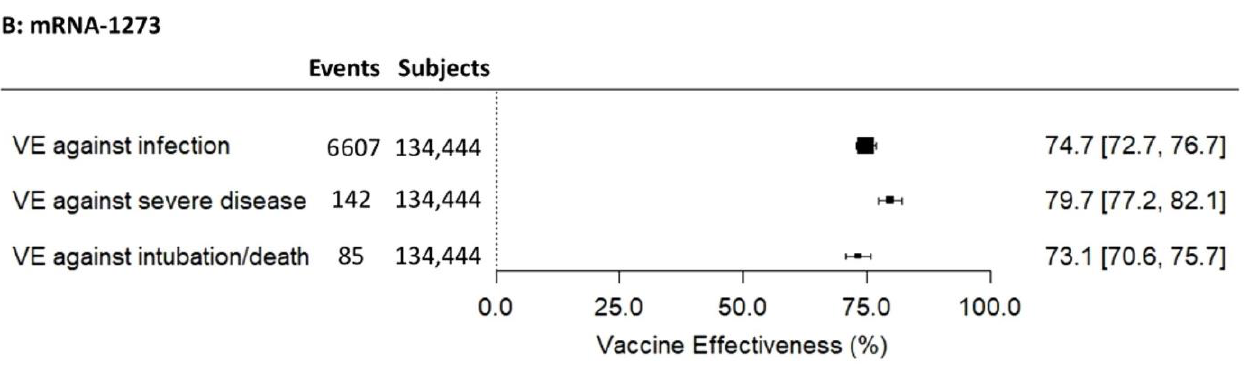
Figure 2. Vaccine effectiveness (VE) of the booster dose against SARS-CoV-2 infection, severe COVID-19, and intubation/death related to COVID-19 in patients vaccinated with BNT162b2 ( A ) and mRNA-1273 ( B ).